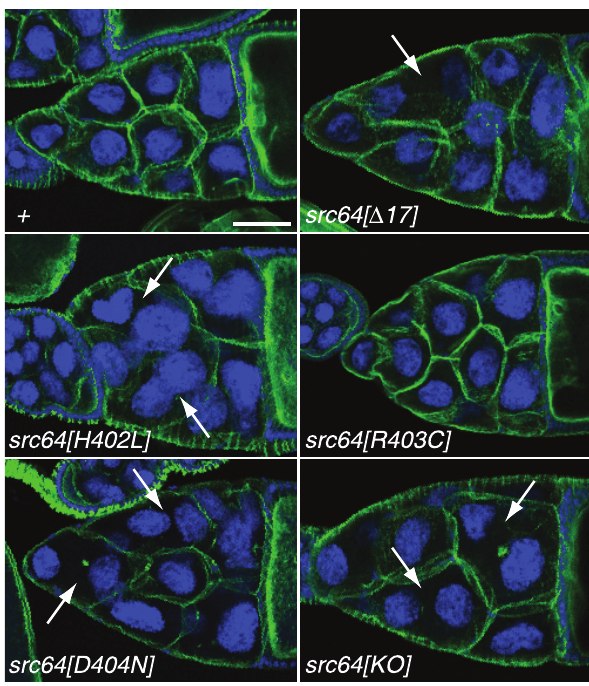
Figure 2. Nurse cell fusion defects in src64 mutant egg chambers. Egg chambers are stained with phalloidin (green) and Hoechst (blue). Partial confocal projections are shown. Nurse cell fusion (arrows) occurs in src64 D 17 , src64 H402L , src64 D404N and src64 KO mutants. Nurse cell fusion does not occur in src64 R403C mutants. Scale bar, 50 m m.